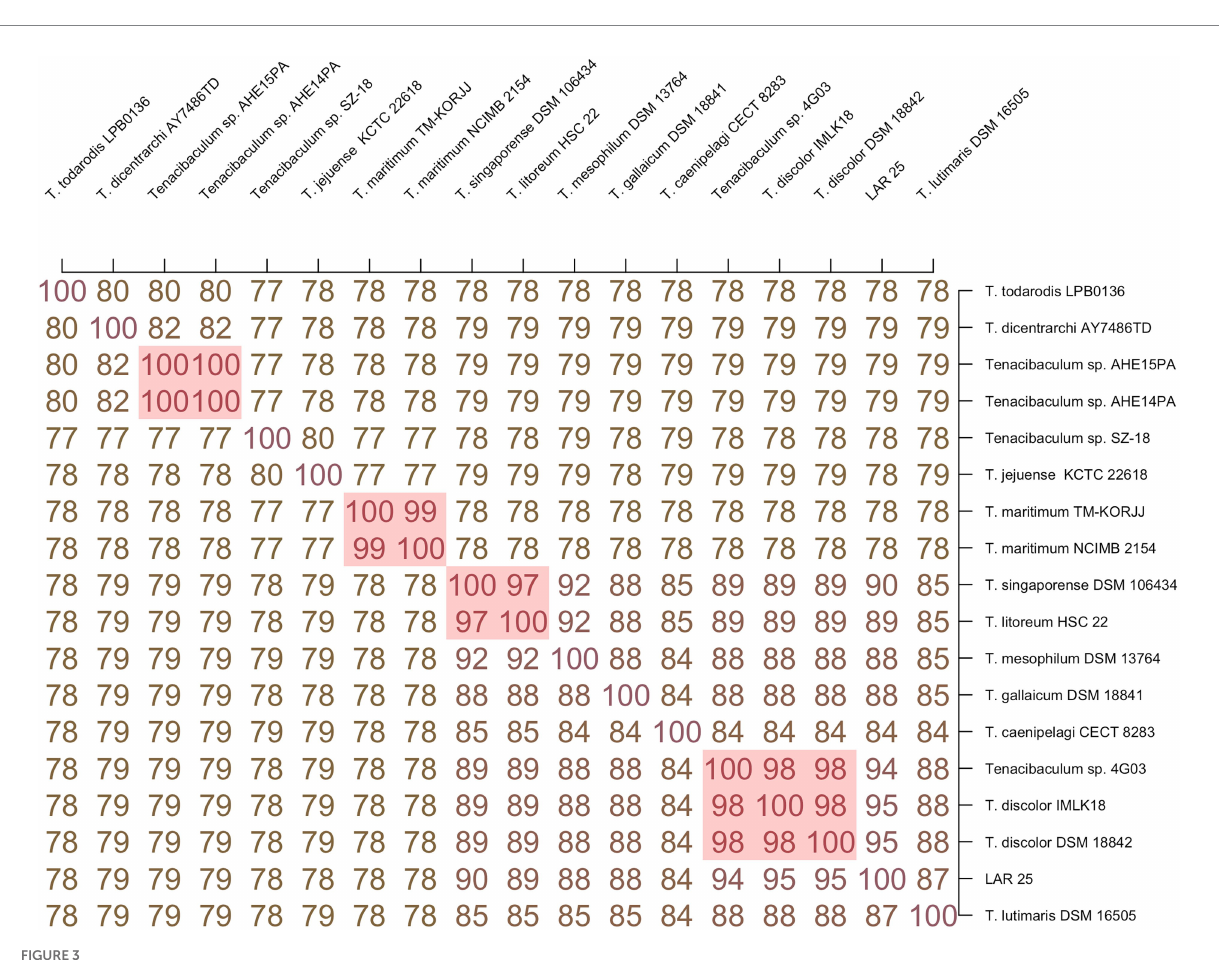
FIGURE 3 Genome similarity ANI-Matrix of LAR25 and 17 genomes Tenacibaculum